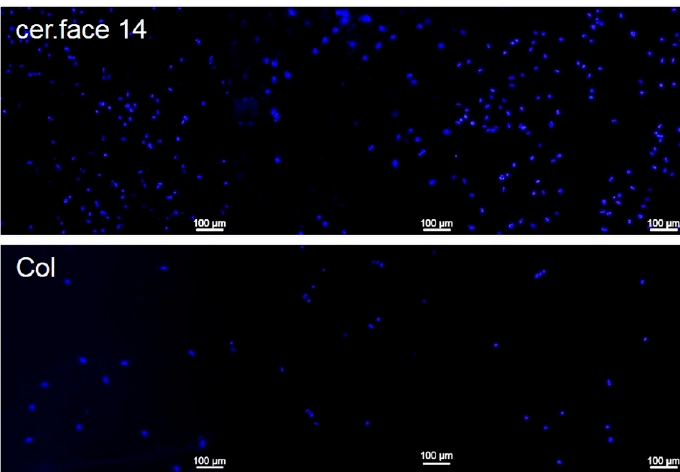
Figure 5. Cell adhesion on the cer.face 14 ceramic. Note that a lot of residual, adhered cells (nuclei in blue, DAPI staining) can be seen that withstood the normal trypsination process due to their embedding in the nano-micro structured surface (n = 180 ± 90); in comparison, cells on a Col-coated plane surface are removed nearly completely (n = 26 ± 14), which is significant with p < 0.01. Detection via confocal scanning microscopy (LSM 780, Carl Zeiss, sale bars 100 µm).